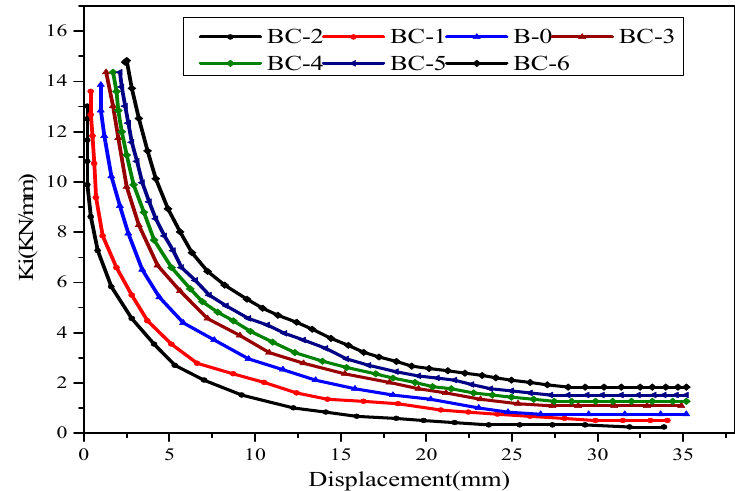
Figure 10. Sti ff ness degradation for unstrengthened and strengthened Figure 10. Stiffness degradation for unstrengthened and strengthened beams.